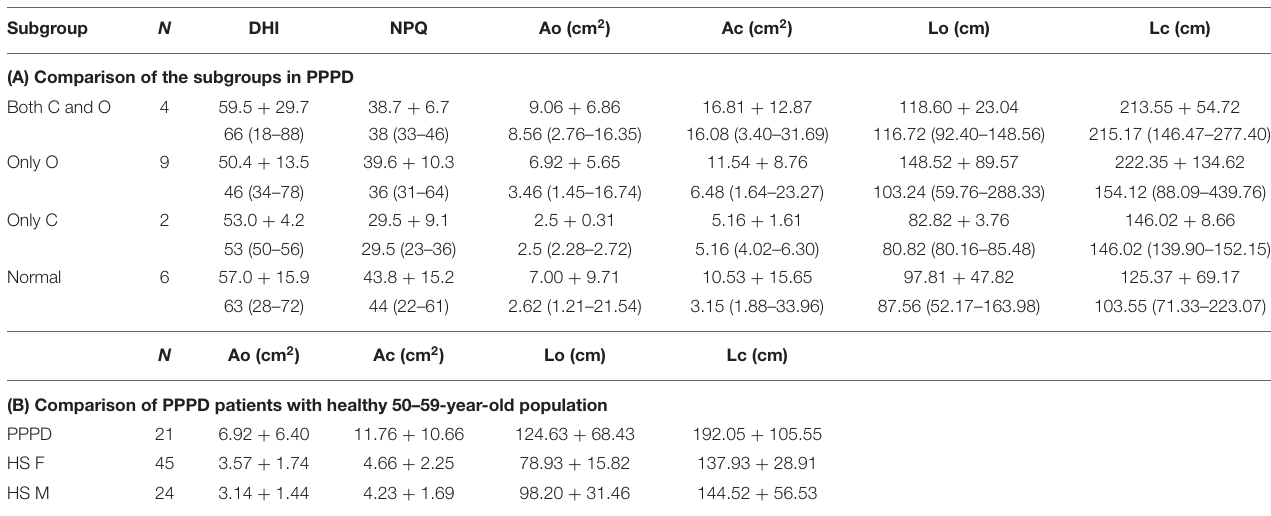
TABLE 3 | Summary of questionnaires and stabilometry.